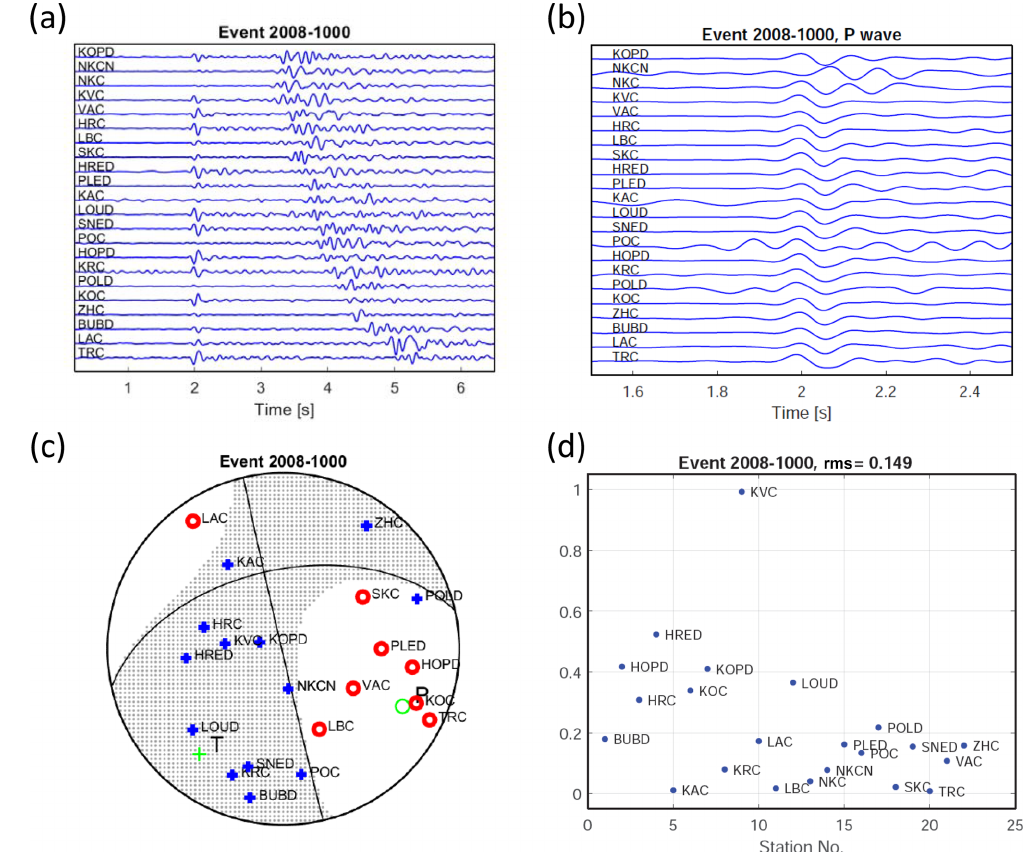
Figure 12. Example of plots provided for each earthquake in the dataset. (a) Vertical components of complete waveforms recorded at the WEBNET stations and aligned according to the arrival time of the P wave. Stations are sorted according to their epicentral distance. (b) Vertical components of the P waves aligned according to their arrival time and with polarity switched according to the polarity of the common wavelet. (c) The focal mechanism with positions of the stations on the focal sphere (negative polarities – red circles, positive polarities – blue plus signs). (d) Root-mean squares (rms’s) of the differences between the theoretical and observed amplitudes of the P